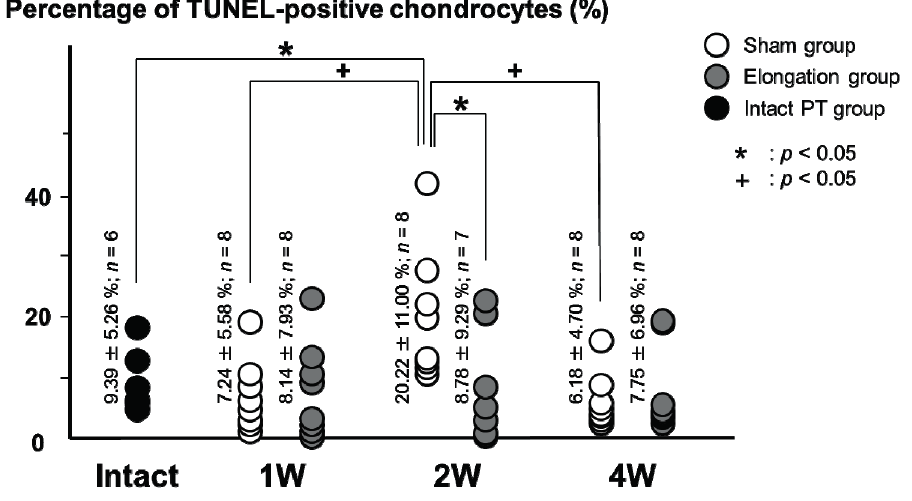
Figure 2. Proportion of TUNEL-positive cells. The average percentages of TUNEL-positive chondrocytes in the sham group was significantly higher than that in the elongation group at 2 weeks ( p = 0.025) and that in the intact PT group ( p = 0.023). In the sham group, the average percentages of TUNEL-positive chondrocytes was significantly higher at 2 weeks as compared with 1 week ( p = 0.007) and 4 weeks ( p = 0.047).